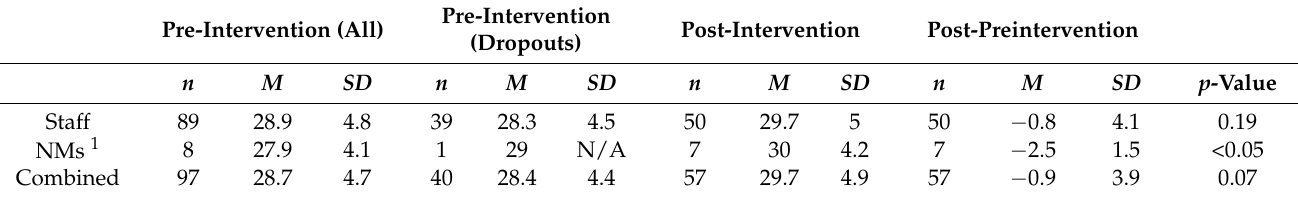
Table 7. Pre-to Post-intervention Resilience Score